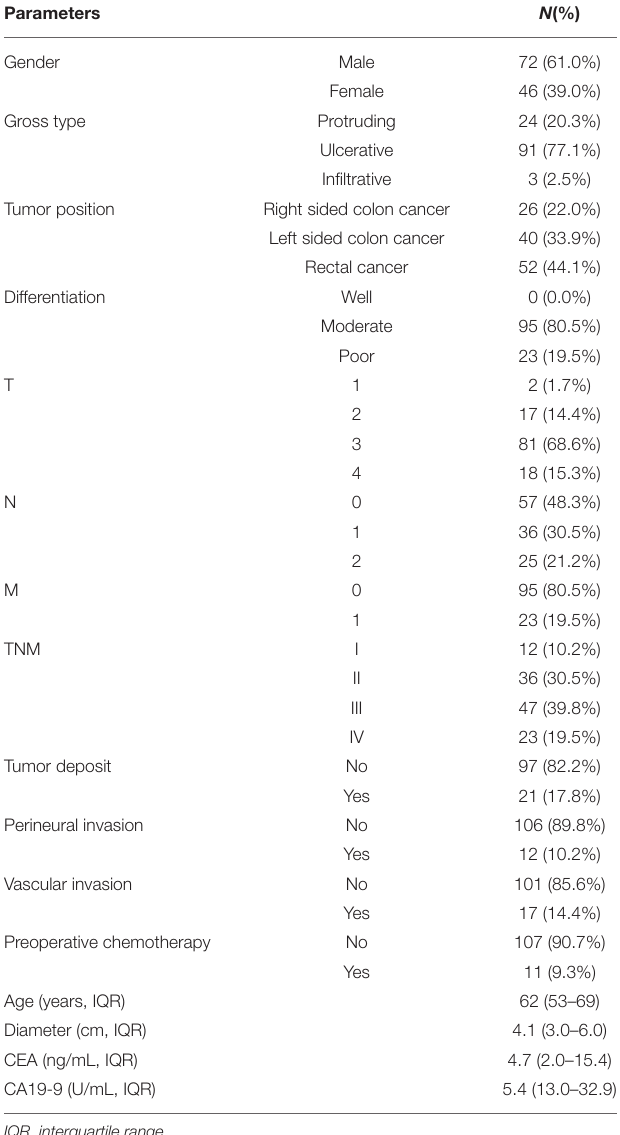
TABLE 3 | Clinicopathological characteristics of patients included in the